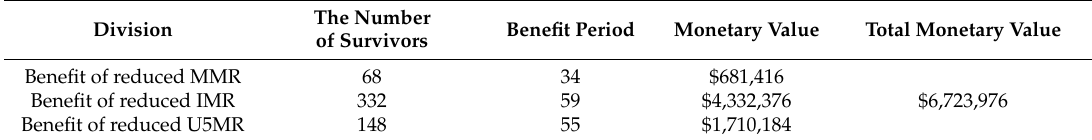
Table 3. Benefit estimation for the MCH project (2014–2016).